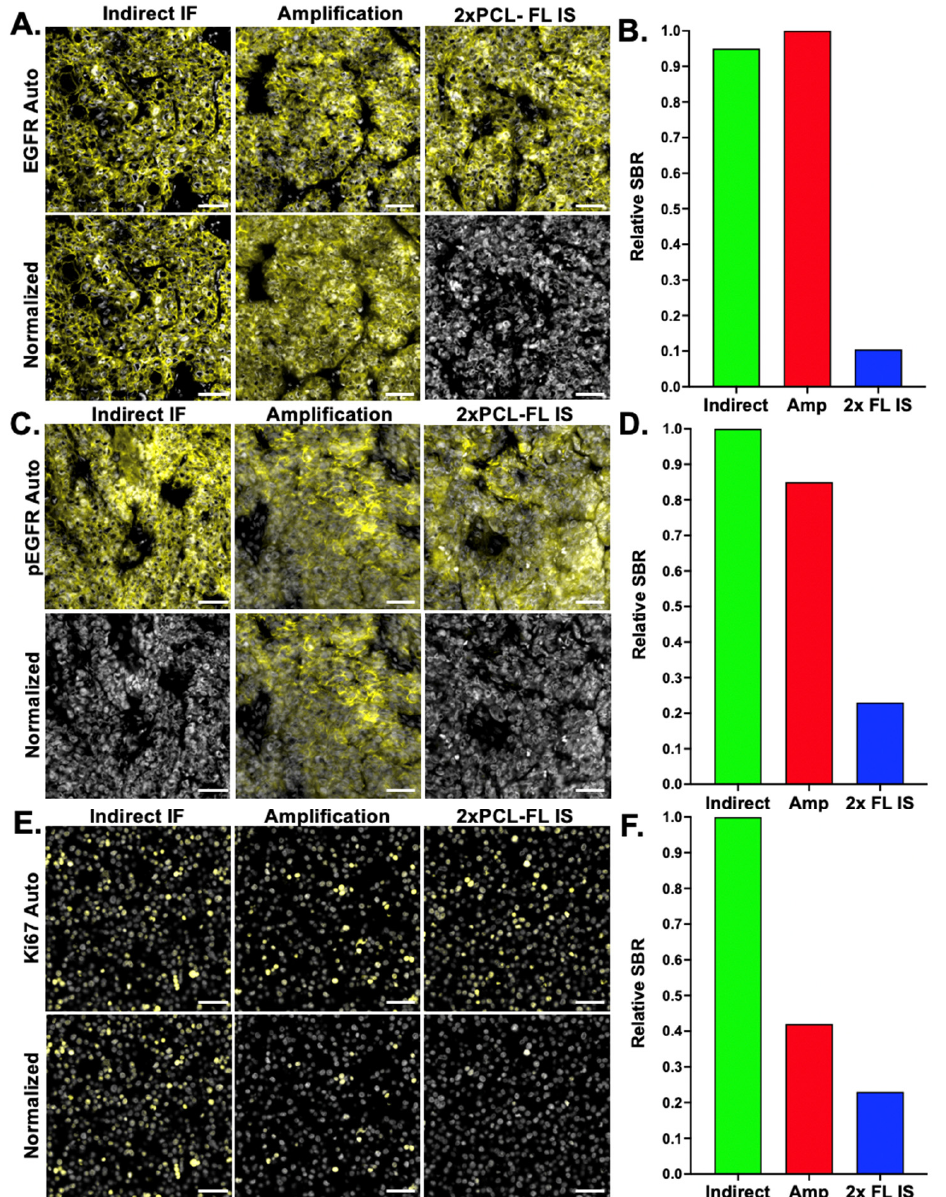
Figure 3. Ab-oligo amplification strategy evaluation . The staining pattern and the signal-to- background ratio (SBR) produced by the Ab-oligo amplification strategy was assessed by comparing it to conventional indirect IF and the Ab-oligo conjugate detected using the complementary imaging strand with the 2 × PCL-FL IS in A431 mouse xenograft tissues. ( A ) An EGFR-specific staining pattern (EGFR = yellow and DAPI = white) was verified for all staining methods and ( B ) signal intensity was quantitatively assessed for this membrane-bound marker. Similarly, ( C ) the pEGFR staining pattern (pEGFR = yellow and DAPI = white) and ( D ) signal intensity quantification was performed to assess the amplification of a cytosolic protein. ( E ) The Ki67 staining pattern (Ki67 = yellow and DAPI = white) and ( F ) signal intensity quantification were also evaluated for the amplification of a nuclear marker. Staining pattern verification images are displayed with auto-contrast settings for optimal visualization (Auto) and with normalized signal intensity per antigen to compare staining intensity between methods (Normalized). Images shown are representative of multiple fields of view and quantification results are reported as a representative average. Scale bar = 50 µ